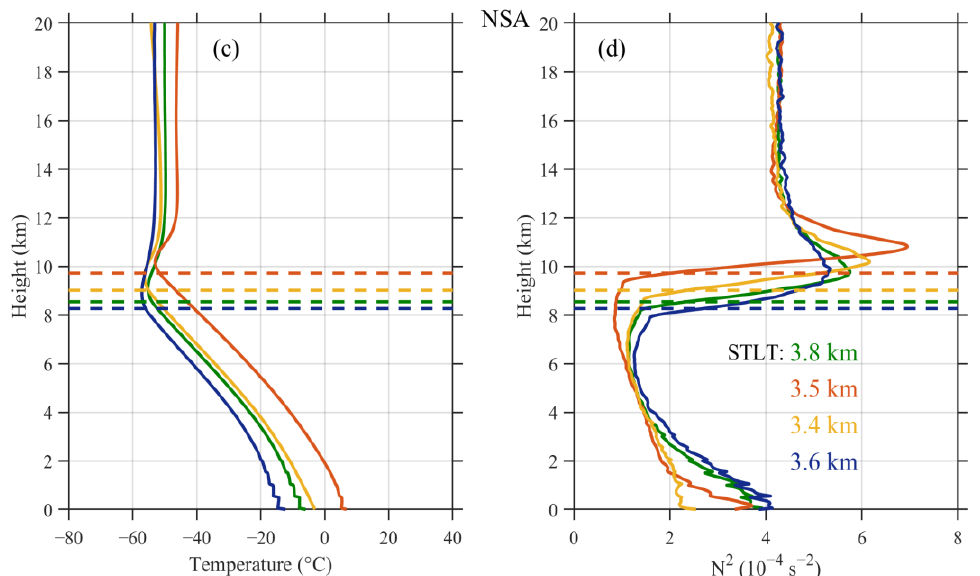
Figure 4. Seasonally averaged climatologies of the temperature ( a ) and stability ( b ) with respect to the tropopause heights at SGP; panels ( c , d ) are similar to ( a , b ) but at NSA. The vertical solid lines in green, red, yellow, and blue denote the seasonal variations in spring, summer, autumn, and winter, respectively, with the horizontal dashed line indicating the seasonal tropopause height. The depths of the stability transition layer around the tropopause (abbreviated as STLT in the figure) at SGP and NSA are also noted in the right two